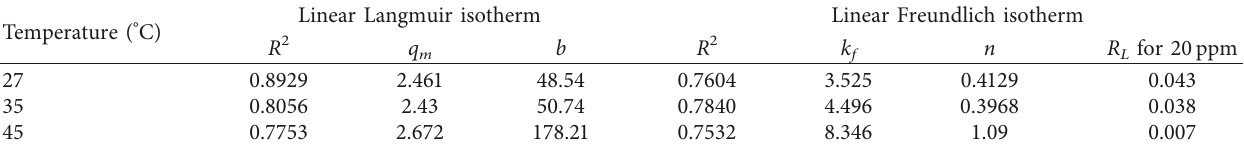
Table 5: Linear Langmuir and Freundlich isotherm parameters at different temperatures.